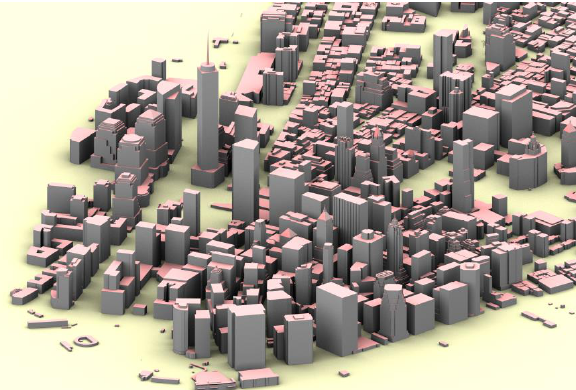
Figure 11: OpenStreetMap 3D: tiled view using global